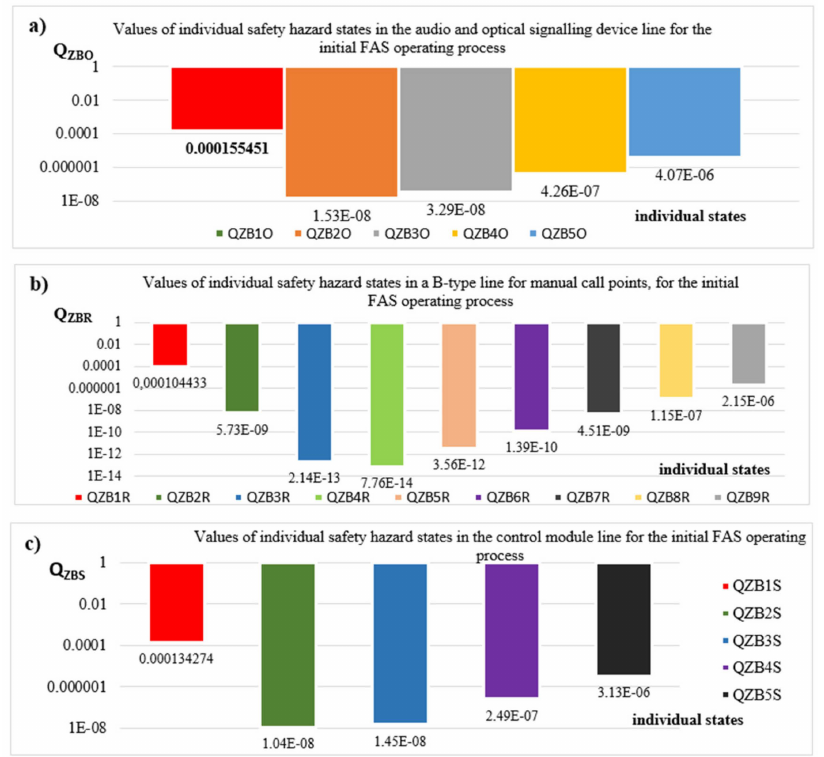
Figure 20. Values of individual safety hazard states in a focused FAS, for individual B-type lines of the system: ( a ) audio and optical signaling line, ( b ) manual call point line, ( c ) control module line (own